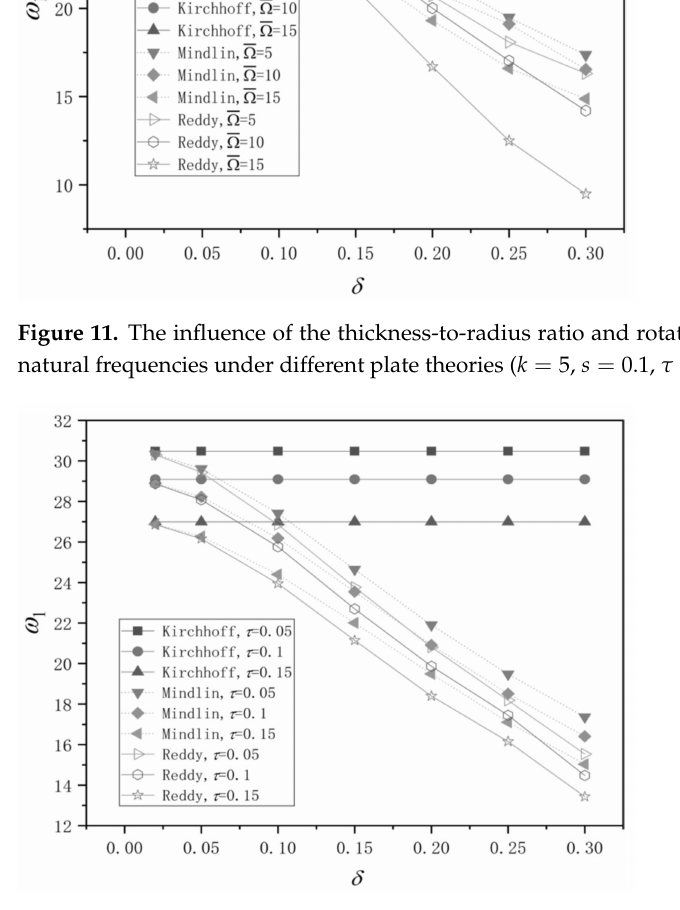
Figure 12. The influence of the thickness-to-radius ratio and nonlocal parameter on the first-order natural frequencies under different plate theories ( k = 5, s = 0.1, Ω = 5, ∆ T = 0